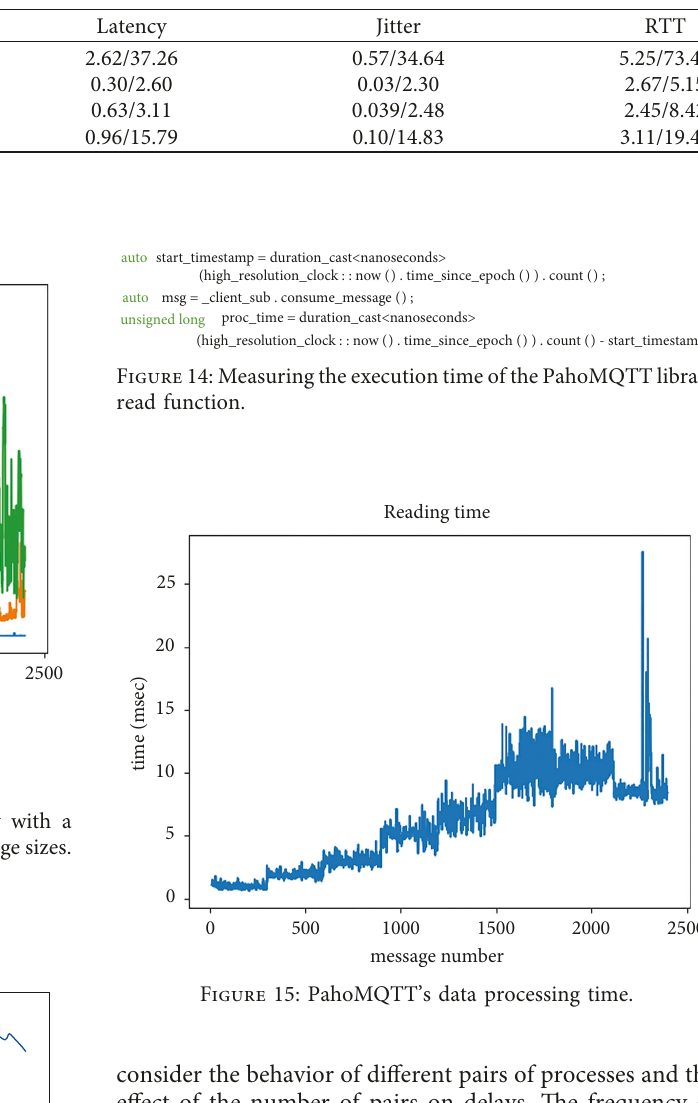
Table 4: Latency, jitter, and RTT of minimum message size.